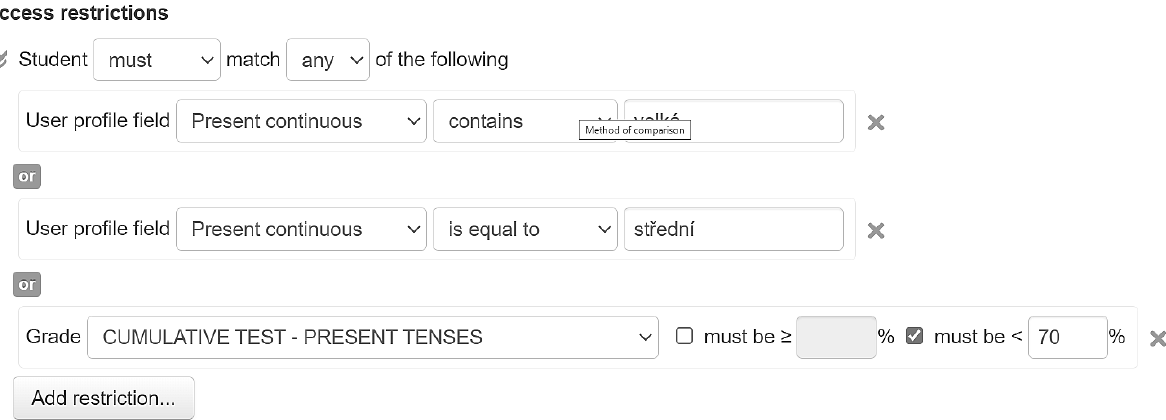
Figure 8. Access restrictions to a lesson.